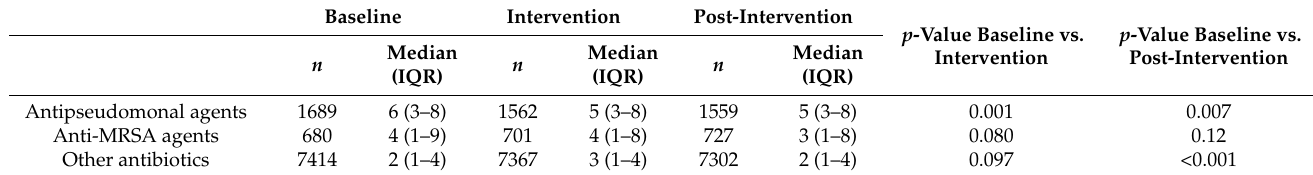
Table 4. Duration of each antibiotic treatment, median days (IQR). Baseline